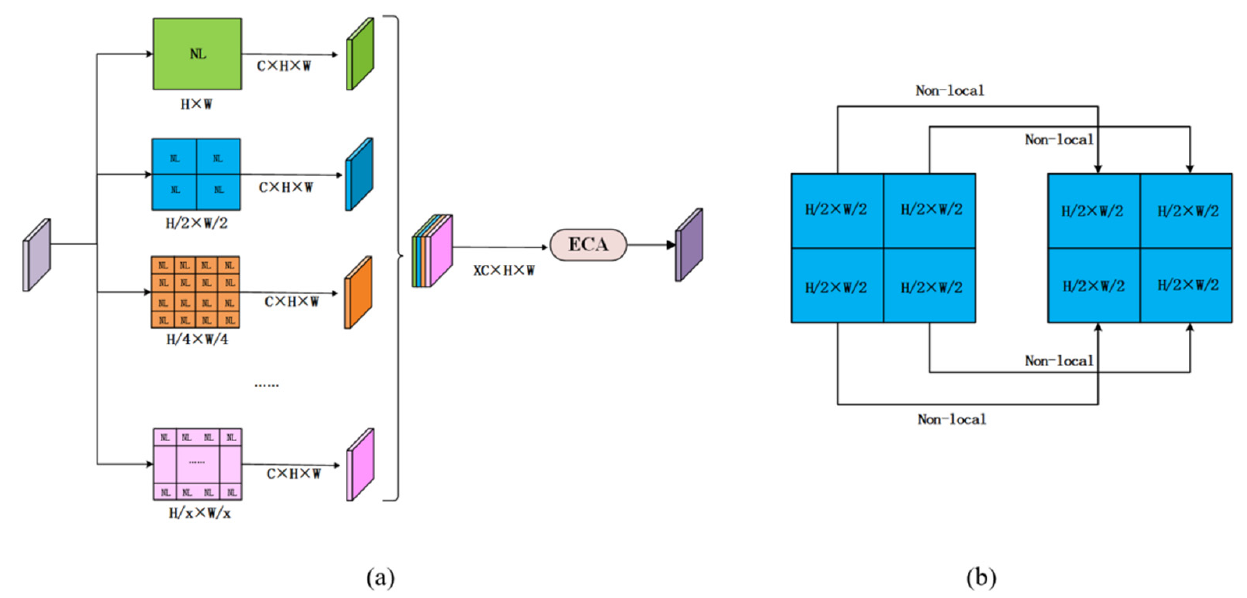
Figure 2. Schematic diagram of Feature Post-Processing Model: ( a ) detailed architecture of FPPM, ( b ) detailed operations on a single block.